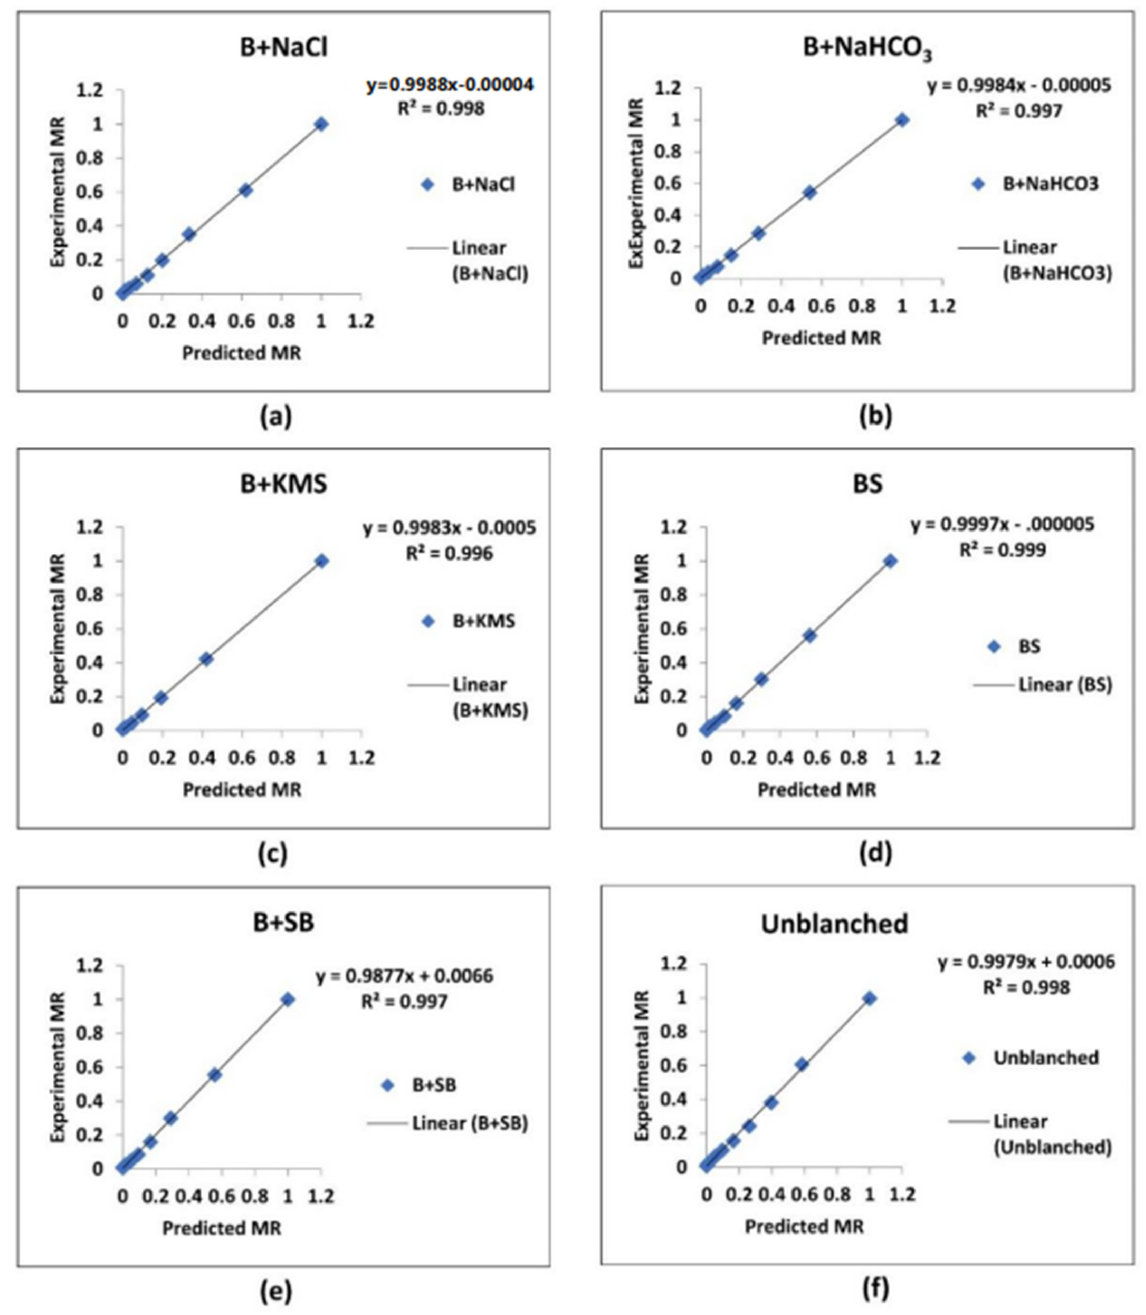
Figure 5. ( a – f ): Plot of experimental moisture ratio against predicted moisture ratio of pretreated and unblanched Moringa leaves at 70 °C using Midilli–Kucuk model for fluidized bed drying.